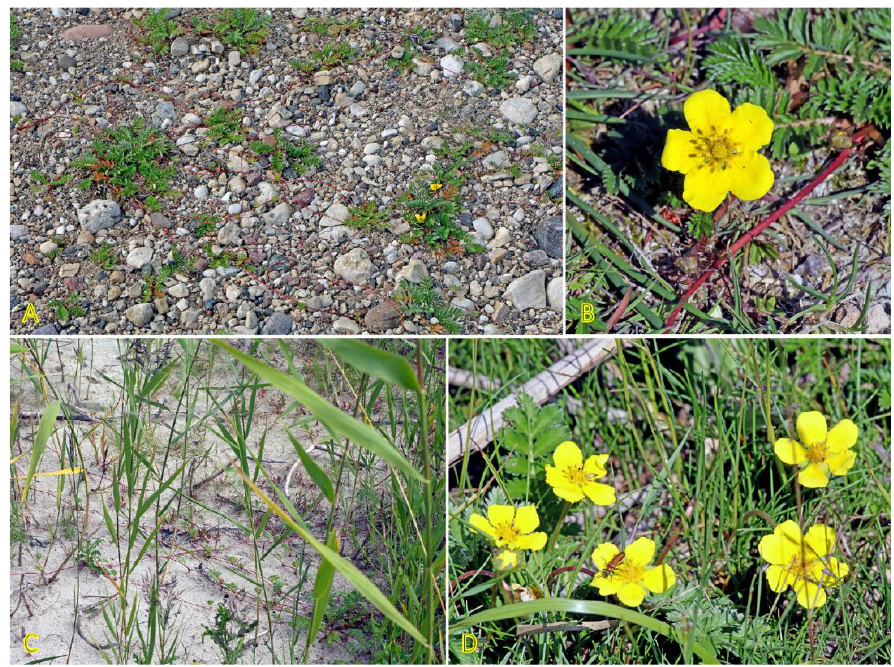
Figure 2. Potentilla anserina plants on a gravel beach on the island of Saaremaa, Estonia ( A ), coastal meadow in M ērsrags, Latvia ( B , D ), and sandy beach in Mērsrags, Latvia ( C ). Plants form leaf rosettes and new stolons in spring. Both stolons and flowers are de- veloped from rosette leaf axils, resulting in a trade-off between generative and vegetative reproduction [60]. Stolons are up to 1 m long on average, usually only one per plant, with 1.7 – 3.0 daughter ramets; however, maximum clonal growth in favorable years can pro- duce 10 stolons with 50 ramets per genet [57]. As a result, P. anserina has a prominent capacity for vegetative spread, forming dominant stands with 2000 ramets per m 2 in coastal meadows [58]. However, plants established from seeds form flowers or stolons